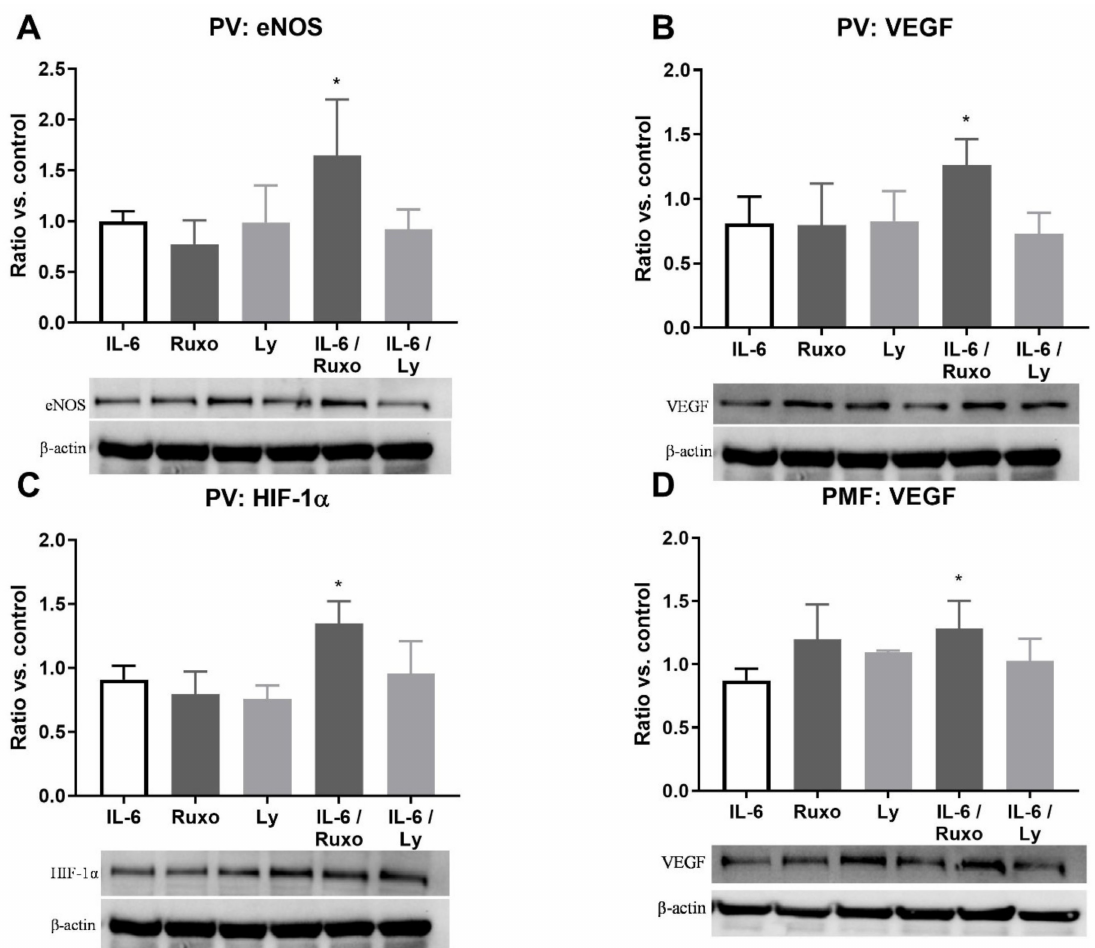
Figure 1. Interleukin-6 (IL-6) induction of angiogenic factors in mononuclear cells (MNC) of myeloproliferative neoplasms (MPN). Densitometry revealed protein expression determined by Western blotting and presented as a ratio of treated to non-treated MNC (Control). The MNC were treated for 1 h by 20 ng/mL IL-6 with or without 1 µ M JAK1/2 inhibitor Ruxolitinib and 5 µ M PI3K inhibitor LY294002 in ( A – C ) polycythemia vera (PV) and ( D ) primary myelofibrosis (PMF). Values are mean ± SEM ( n = 3). * p < 0.05 vs.